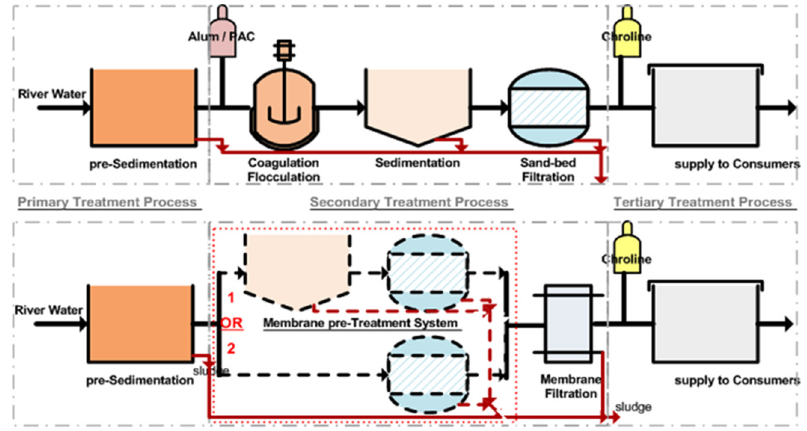
Figure 1. Deep-bed and membrane filtration detailed block diagram of a water-treatment plant.